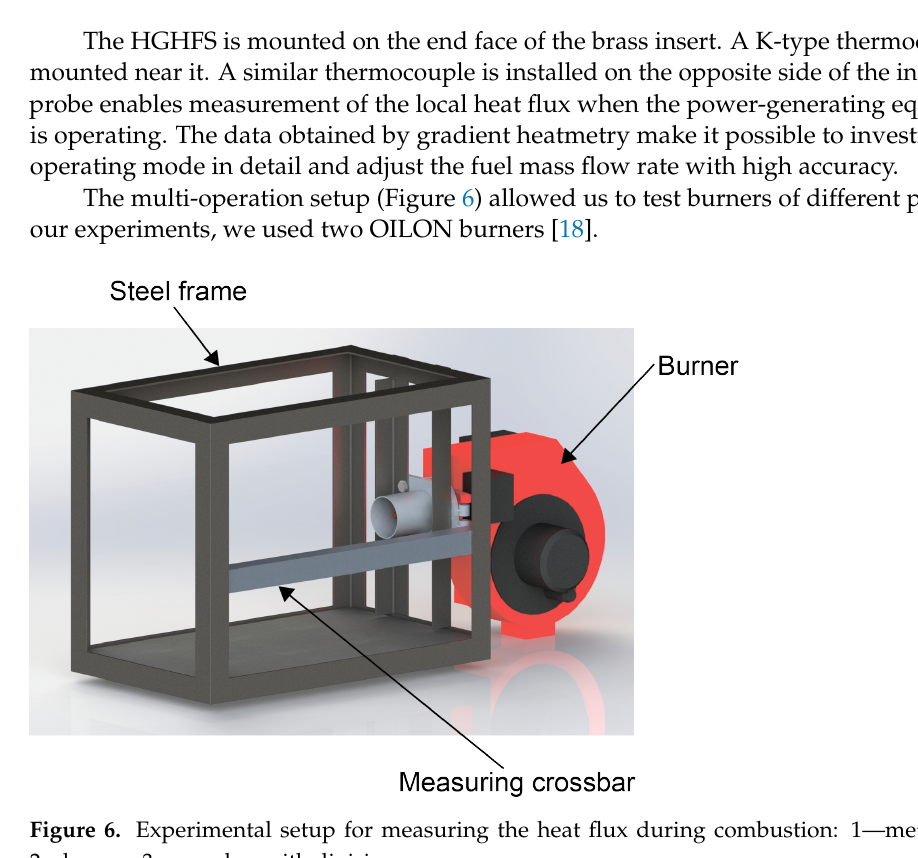
Figure 5. Measurement insert design.